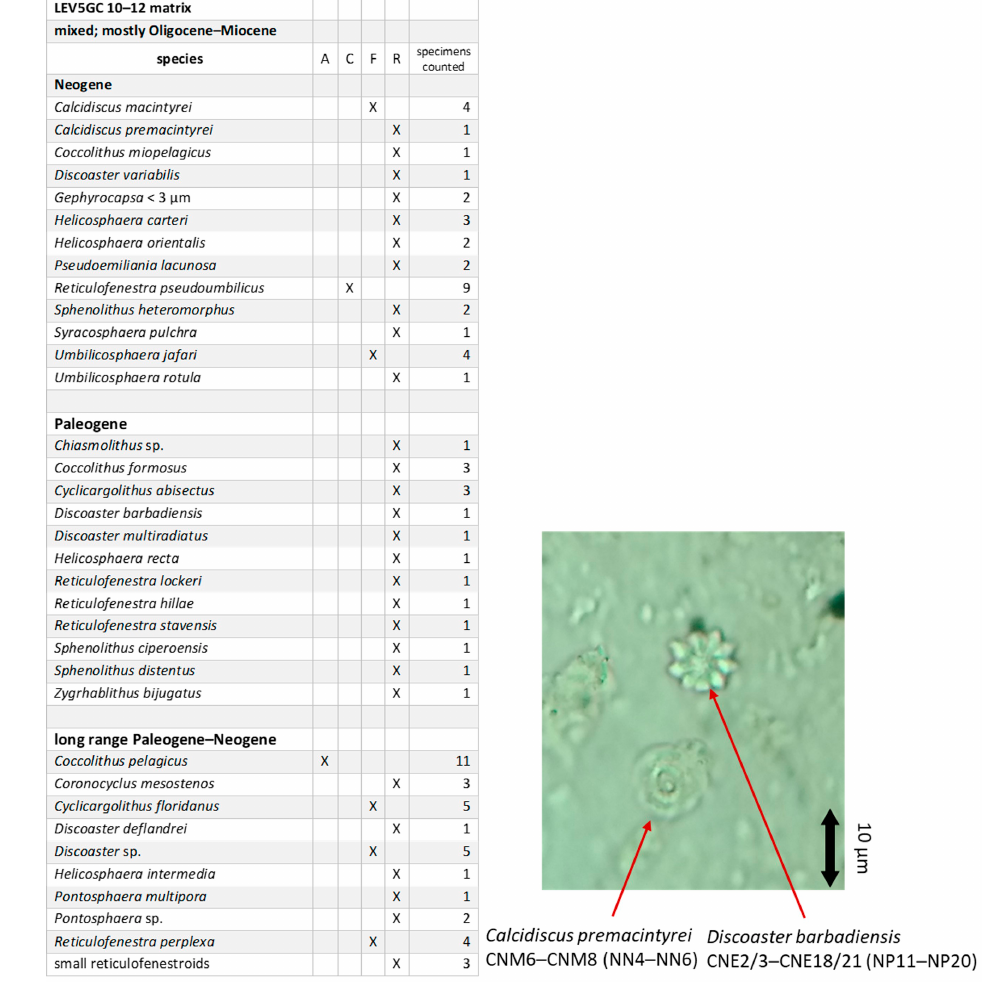
Figure 6. Left: Example of a non-age-diagnostic assemblage list showing the relative abundances of the nannofossil species in the total assemblage of the LEV5GC 10–12 matrix sample. Right: Microscopic image of the sample indicating considerable reworking due to the concomitant occurrence of the Calcidiscus premacintyrei (Miocene) and Discoaster barbadiensis (Eocene) species. Almost all matrix samples displayed analogous microscopic images.